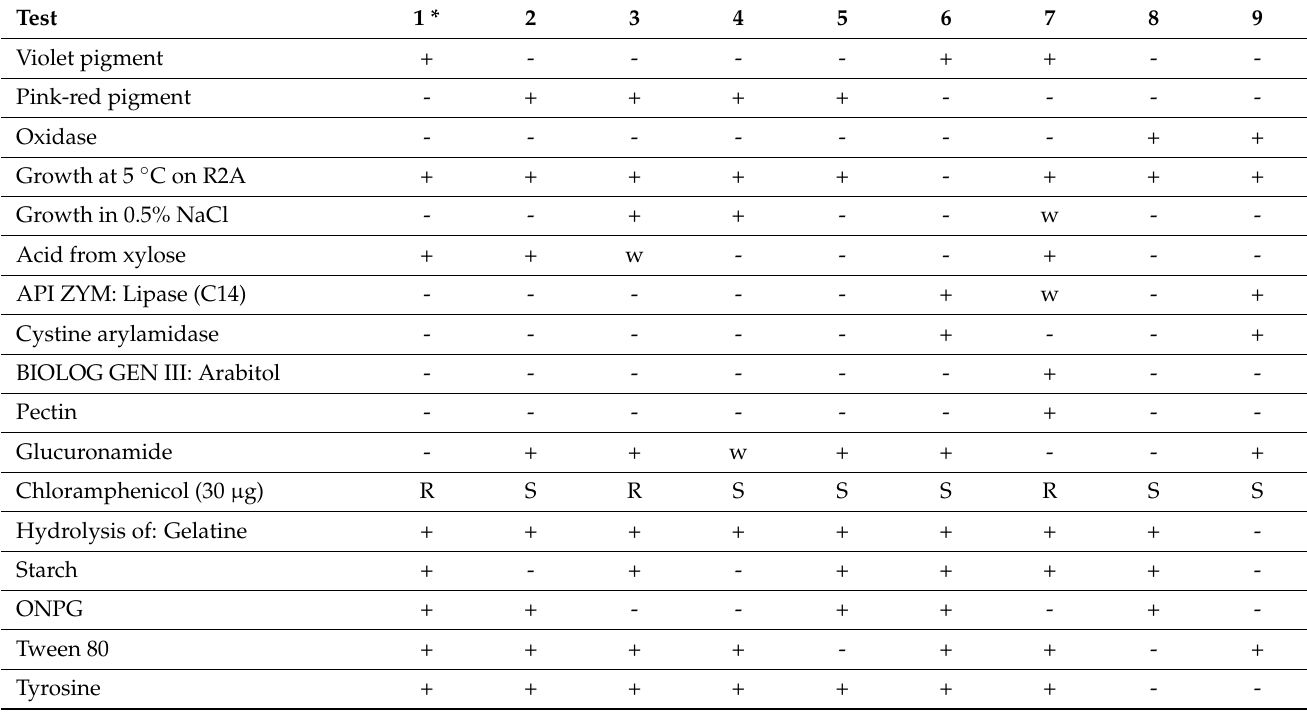
Table 3. Distinguishing properties of Massilia antarctica sp. nov. with types of nearest